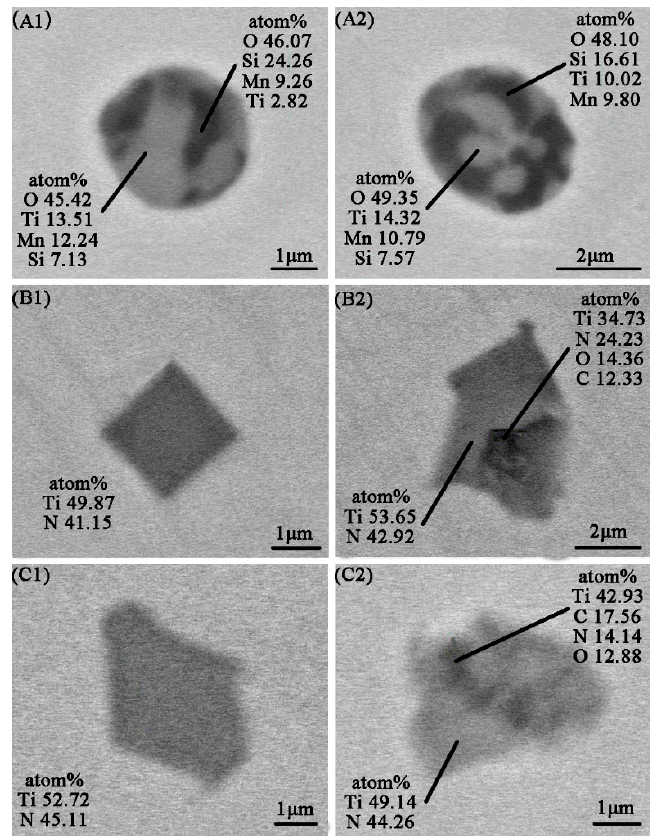
Figure 10. Morphology and type of typical inclusions in samples: ( A1 , A2 ) S1; ( B1 , B2 ) S2; and ( C1 , C2 ) S3.